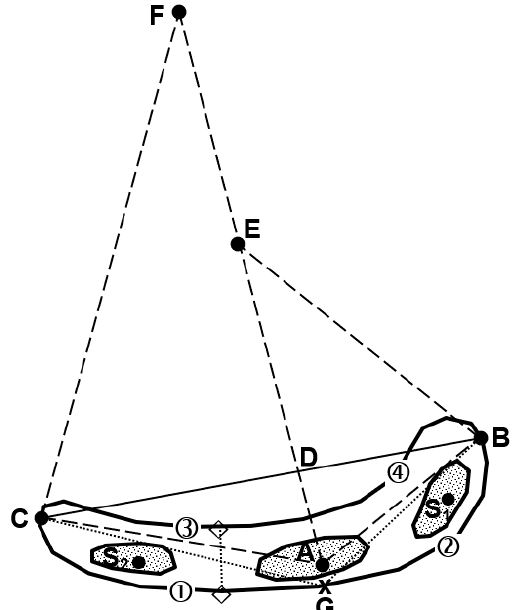
Figure 2. A schematic diagram of an arc-shaped mesoscale rainfall object to illustrate the long axis, the short axis, the radius of curvature and a few other attributes. The thick solid line represents the boundary of the object and the shaded areas represent sub-centers of heavy rainfall identified using a higher threshold value. Point A is the maximum rainfall position inside the object. Points B and C are the two points on the object boundary farthest from each other, and line BC is defined as the long axis. Line AF intersects perpendicularly with line BC at point D, and line BE is perpendicular to AB and line CF perpendicular to AC (thus, ∠ ADB = ∠ ABE = ∠ ACF = 90 ◦ ). The average length of lines BE and CF is regarded as the radius of the curvature of the object. Point G is the apex location (marked by an “x”) on the boundary, which has the longest distance of GB plus GC. Along the boundary at the front (south) side, point 1 (cid:79) is halfway between G and C, and 2 (cid:79) is halfway between G and B. Their shortest distance to the back-side boundary is to points and , respectively. The mean distance